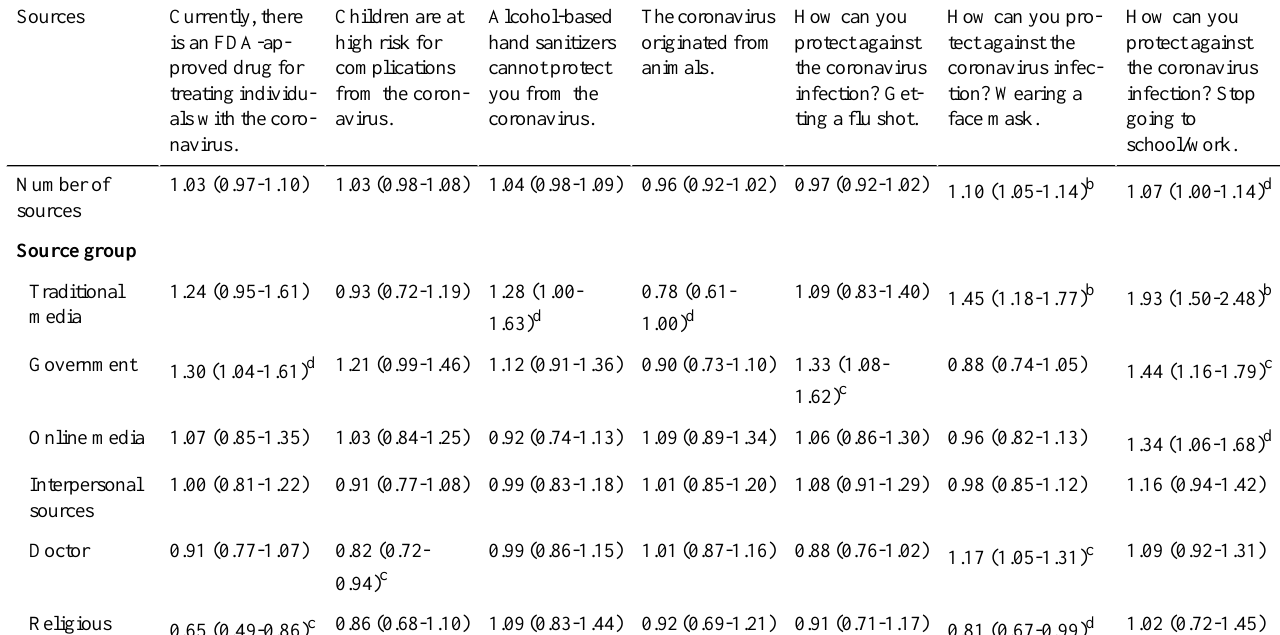
avirus.Currently, there is an FDA-ap- proved drug for treating individu- als with the